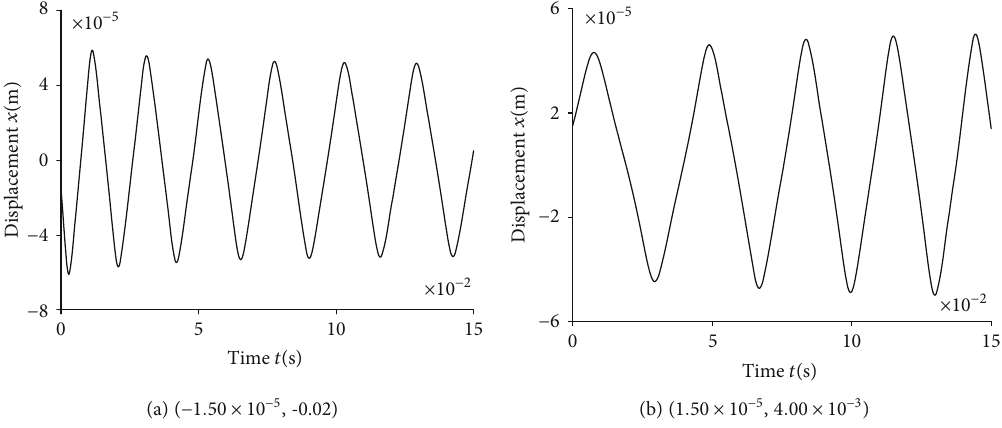
= 8 : 0 × 10 − 5 m , l = 1 : 0 × 10 − 5 m 0